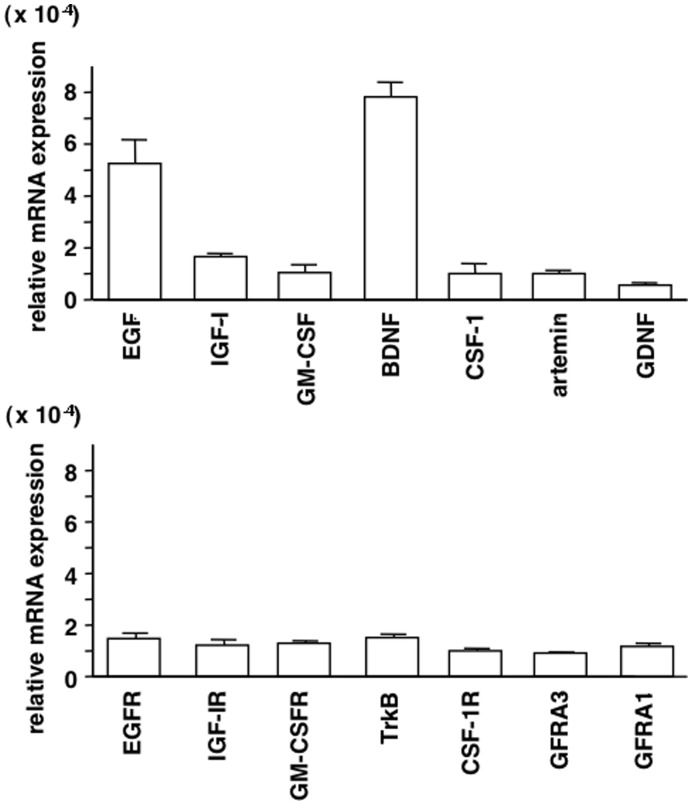
Expresssion of key growth factors and receptors in human blastocysts.Cryopreserved human day 5 embryos were used for quantitative RT-PCR analyses of transcript levels for different ligand-receptor pairs (EGF/EGFR, IGF-I/IGF-IR, GM-CSF/GM-CSFR, BDNF/TrkB, CSF-1/CSF-1R, artemin/GFRA3, and GDNF/GFRA1). Levels of all mRNAs were normalized based on those for β-actin in the same sample (mean ± SEM, n = 3).